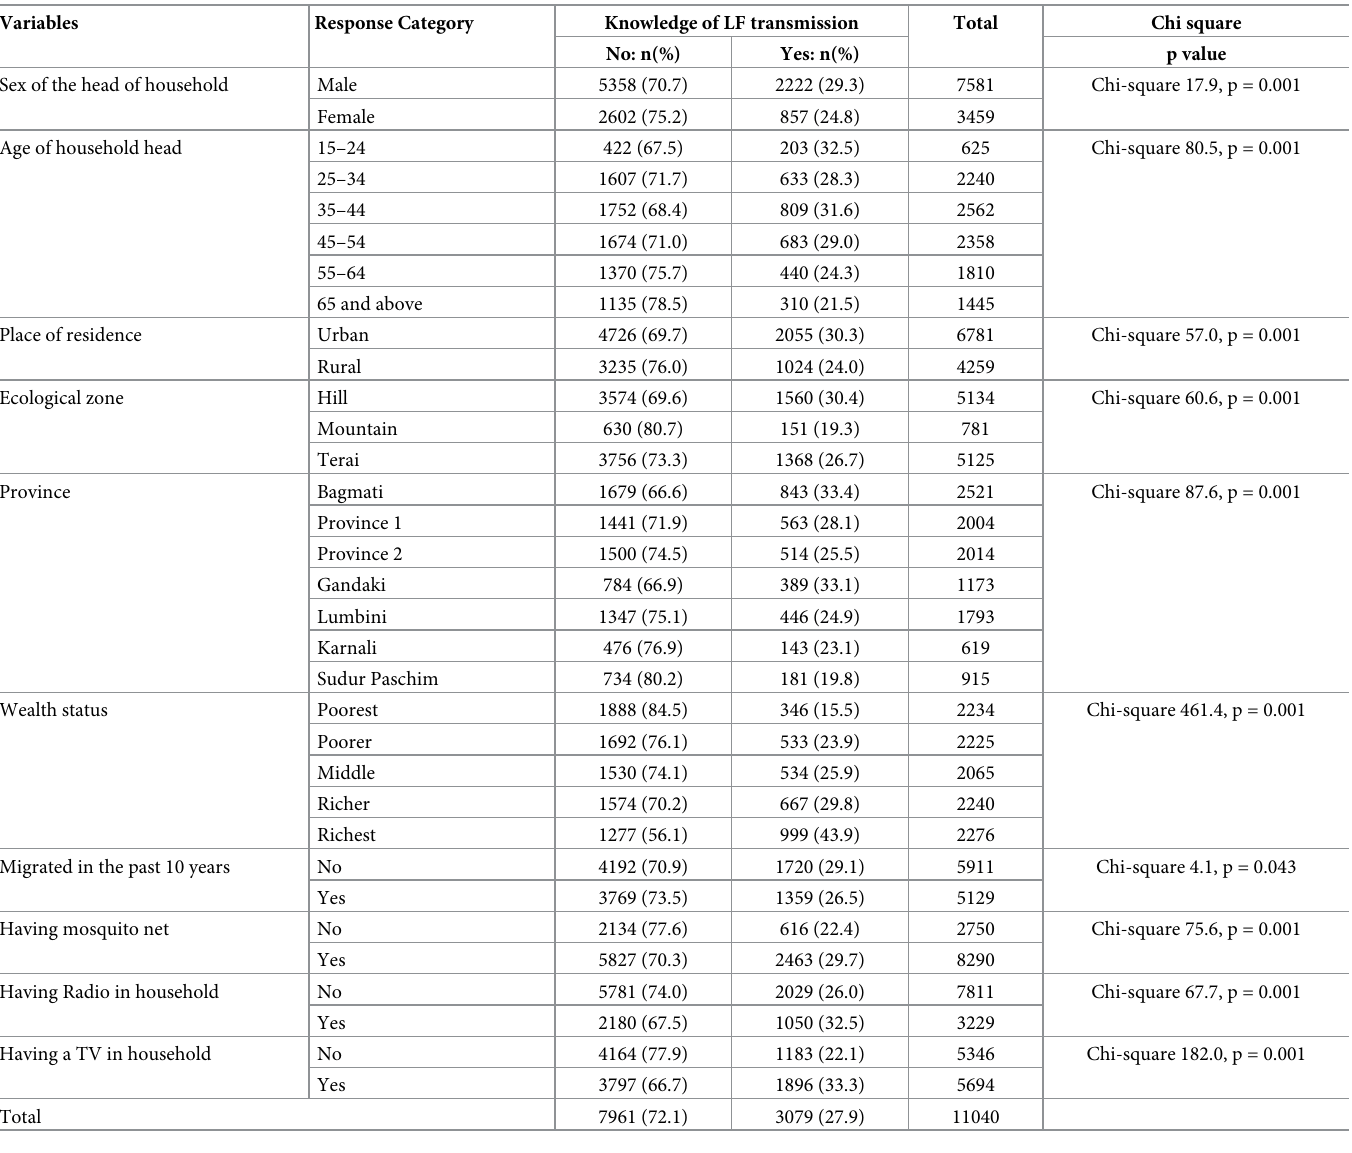
Table 3. Background characteristics of respondents and knowledge of mode of transmission of Lymphatic Filariasis.